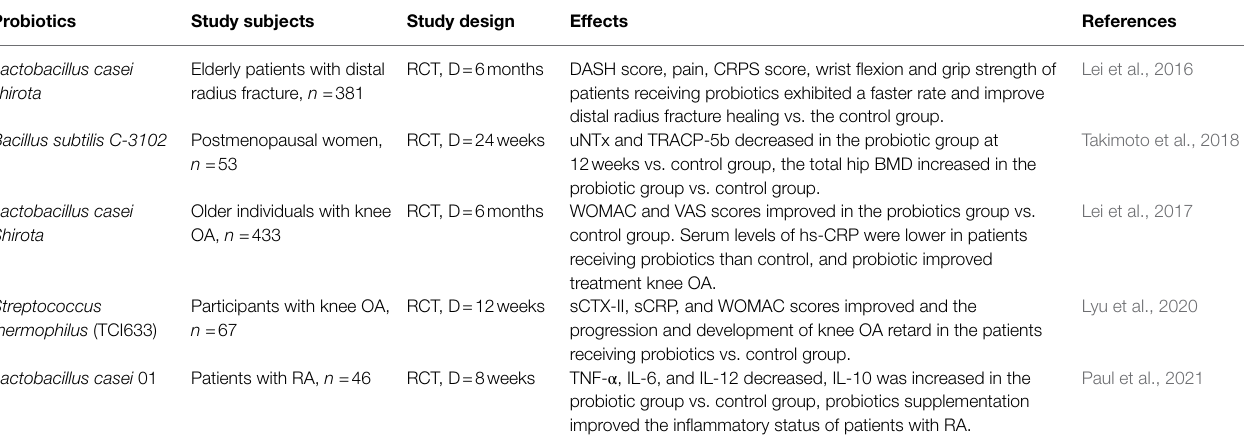
TABLE 1 | Summary of studies evaluating the effects of probiotics on bone outcomes in